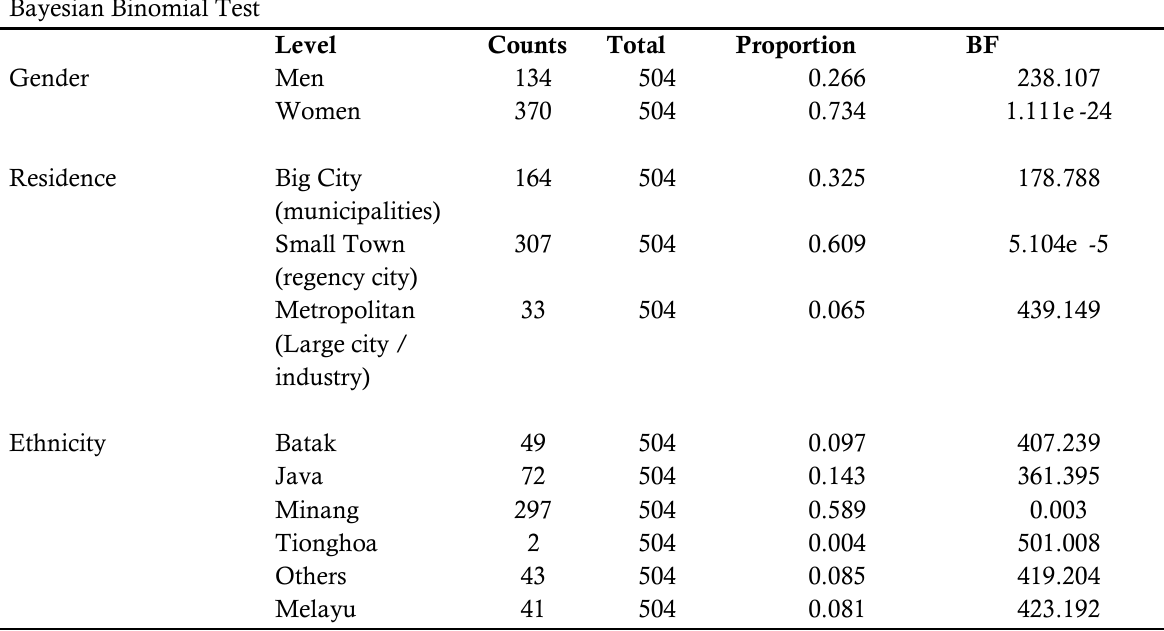
Table 5. Bayesian Binomial